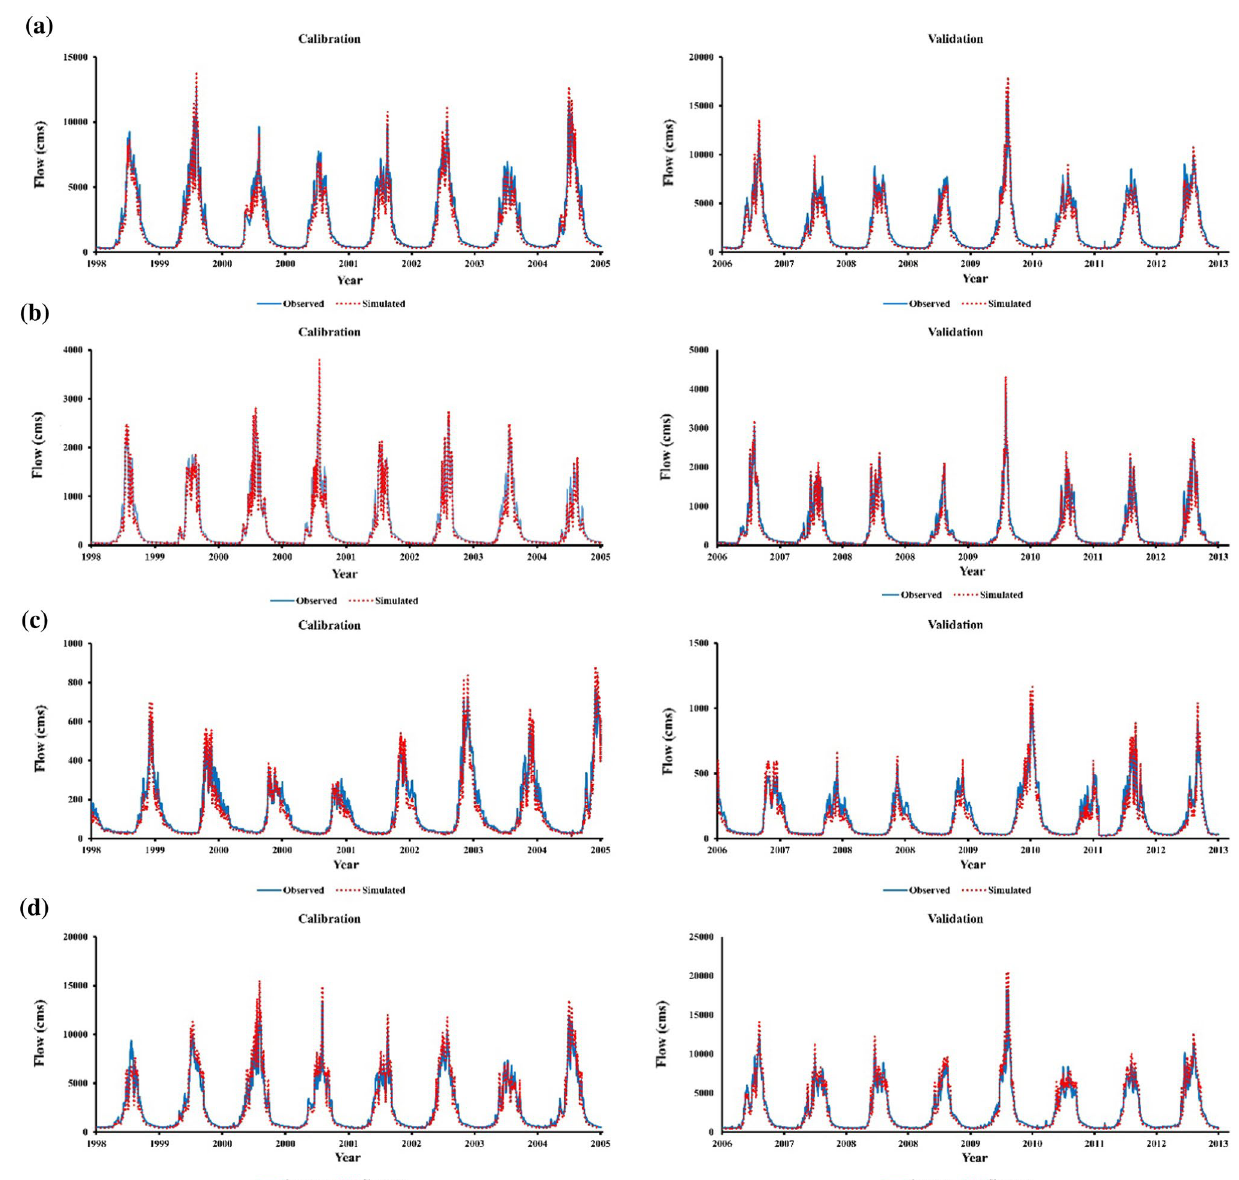
Fig. 4 Calibration (left) and validation (right) of SWAT model across a Shatial bridge, b Yugo, c Doyian, d Bisham Qila